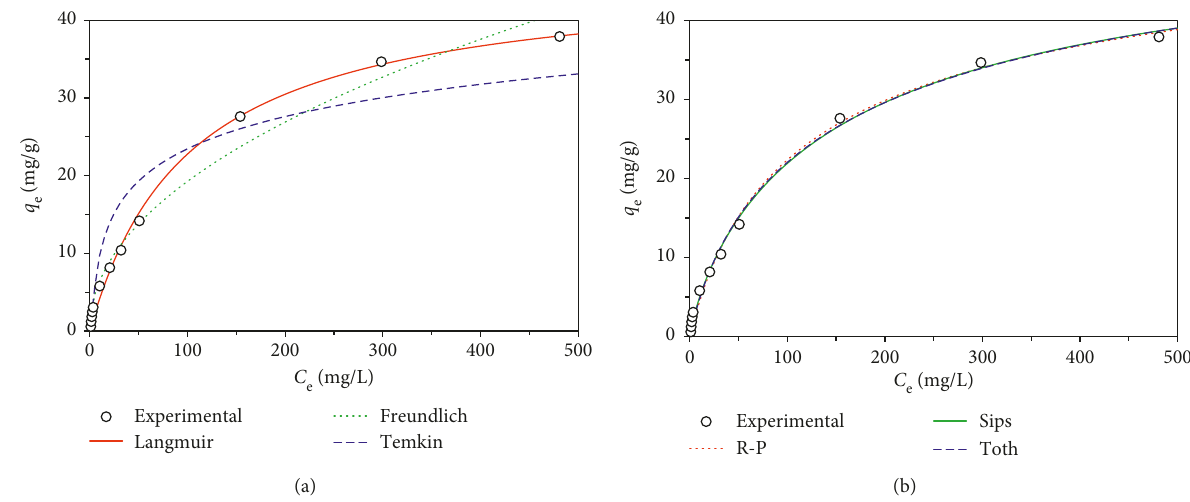
Figure 8: Adsorption isotherms for the NH 4+ uptake on Al-waste-NaP1. Conditions: pH � 7.5; contact time � 15min; adsorbent dos- e � 10g/L; and T � 28 ± 2 ° C. R-P: Redlich–Peterson. Table 2: Isotherm models applied for the NH 4+ adsorption onto Al-waste-NaP1. Two-parameter isotherm model